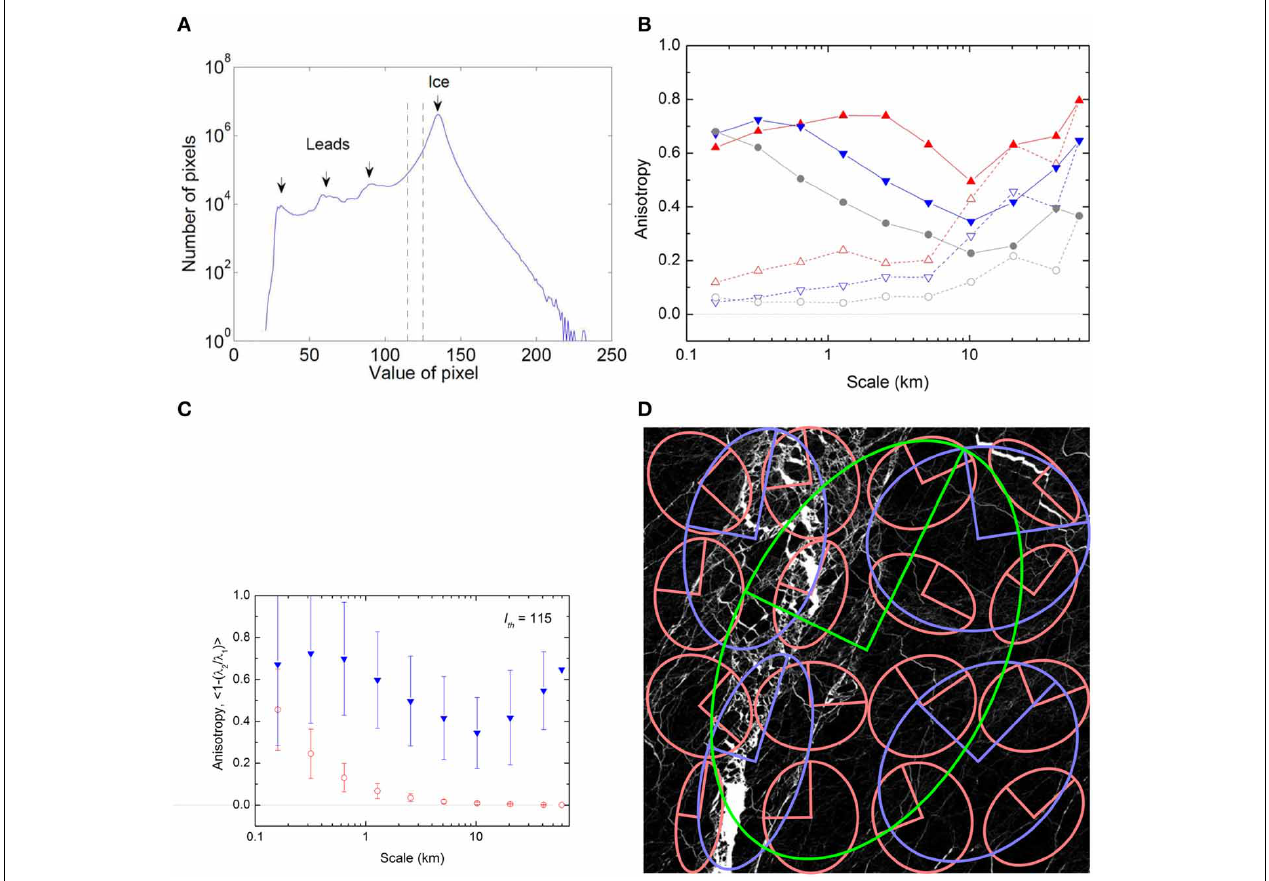
FIGURE 4 | Analysis of the sea ice image (Figure 1A). (A) Gray-level histogram of the raw image. The dashed vertical lines indicate the range of threshold values used for binarization. (B) Anisotropy vs. scale, for different values of the threshold. Solid lines, closed symbols: anisotropy (averaged over all boxes) vs scale for binary images obtained from different thresholds (red upward triangles: I th = 95, blue downward triangles: I th = 115, gray circles: I th = 125). Dashed lines, open symbols: anisotropy of the average tensor, same symbol and color code. (C) Test